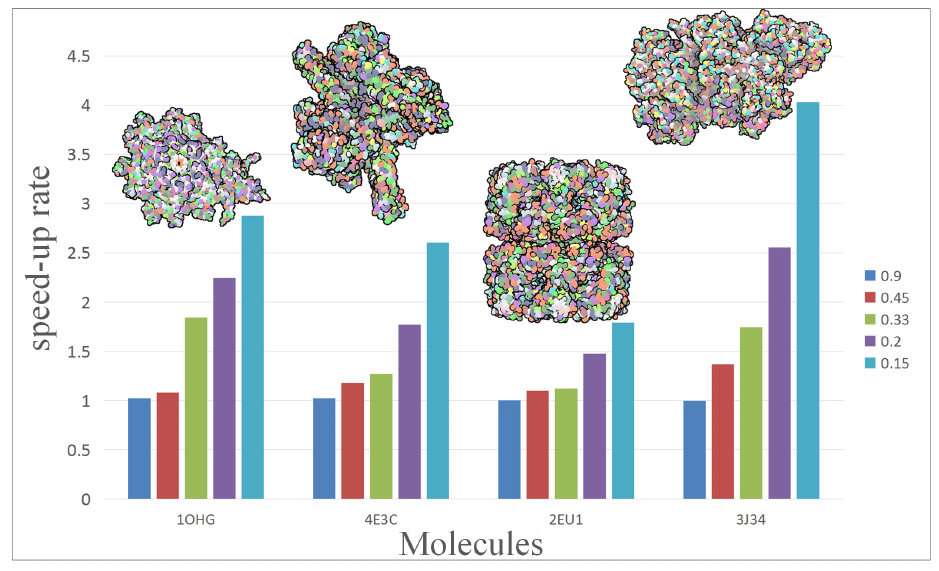
Figure 3. Show the performance improvement of different scale of molecules with different degree of simplification. The molecule contains from left to right: 15,057, 30,416, 53,970 and 75,642